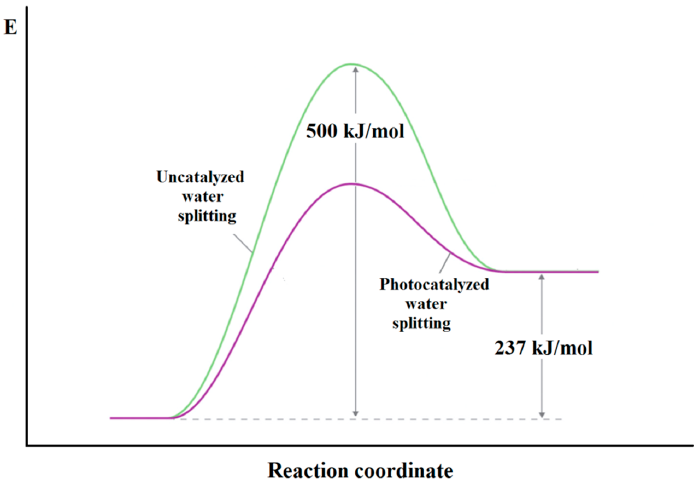
Figure 1. Photocatalytic and non-catalytic energy requirements for water splitting.